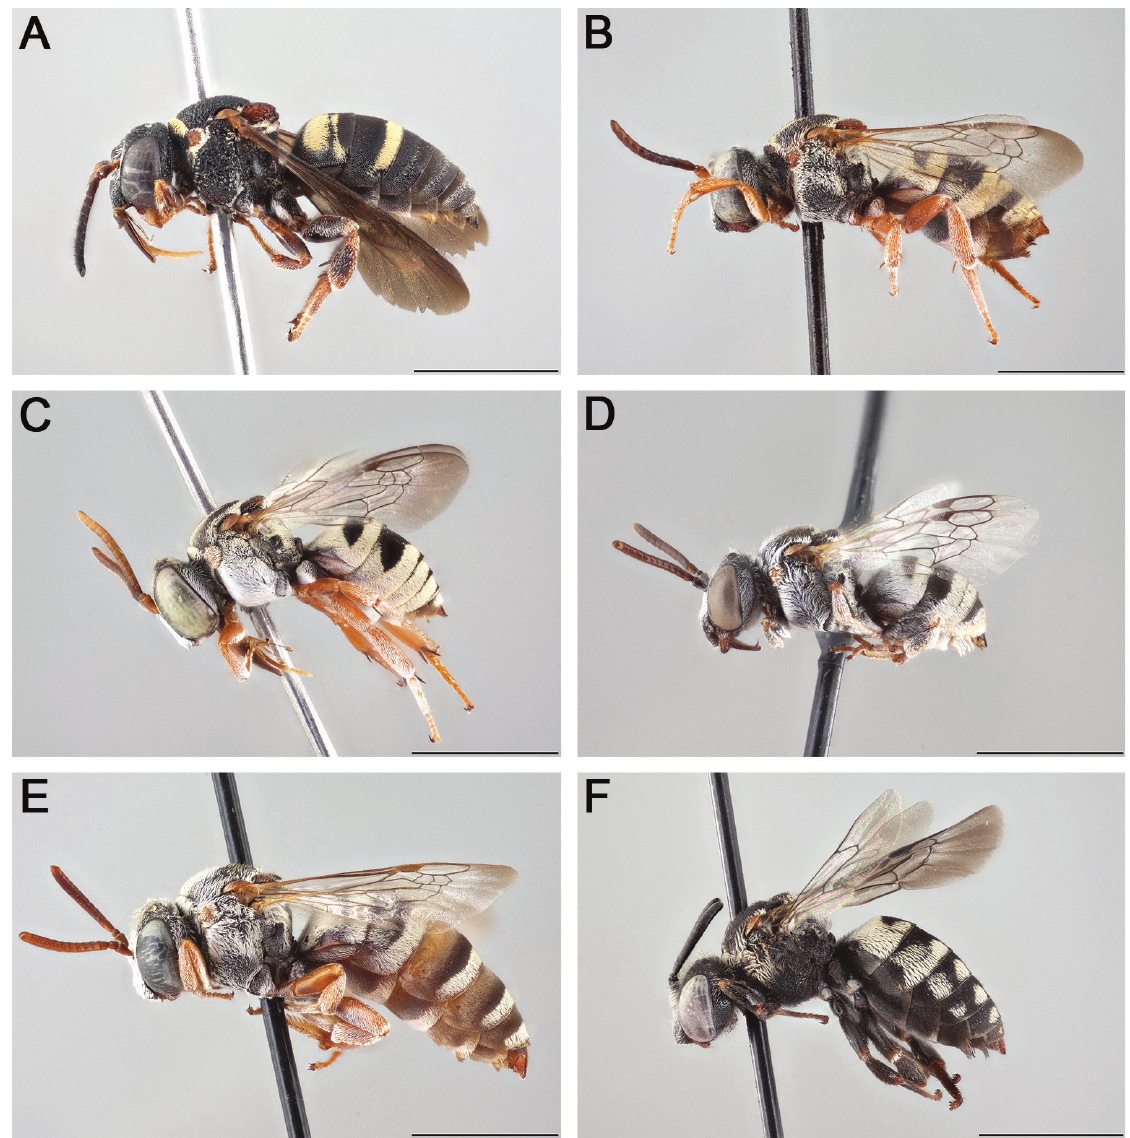
Fig. 20. Epeolus spp., habitus of male, lateral view. A . E. bifasciatus Cresson, 1864. B . E. scutellaris Say, 1824. C . E. basili Onuferko, 2018, paratype. D . E. mesillae (Cockerell, 1895). E . E.